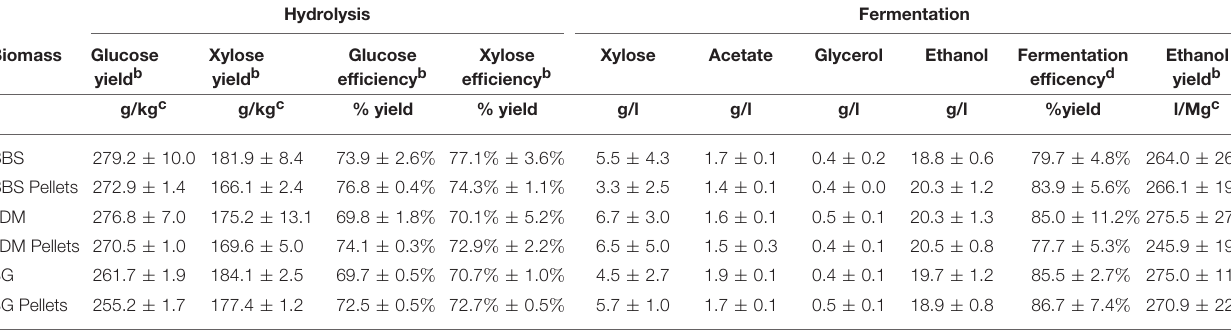
TABLE 4 | Separate hydrolysis and fermentation results for LMA pretreated biomass a . Hydrolysis Fermentation Xylose Biomass Glucose yield yield b